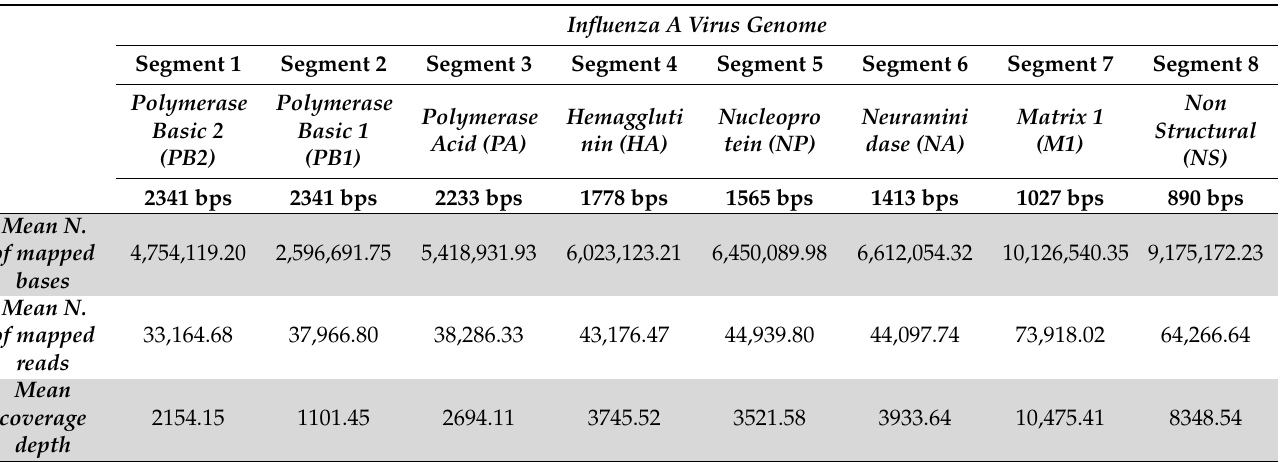
Table 1. Mean number of mapped bases and reads, and average coverage depth for each IAV gene of study samples with viral loads >105 genome copies/mL (72/80,